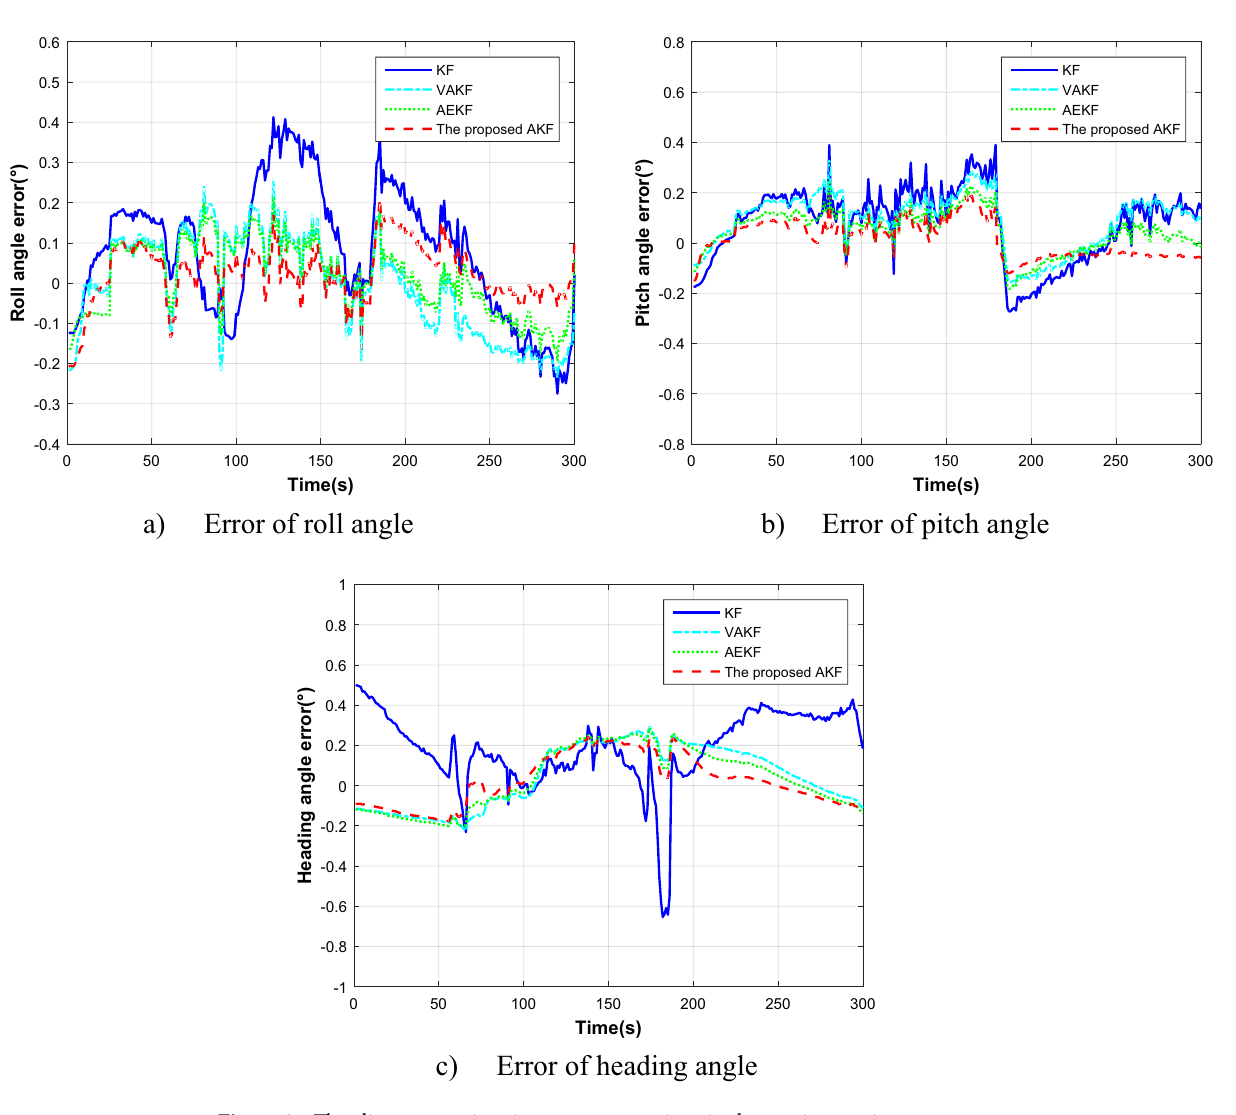
Figure 8. The alignment estimation error comparison in the turning motion.